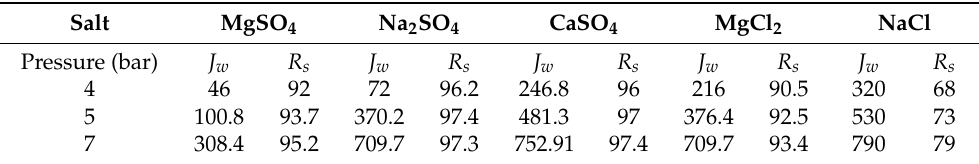
Table 3. The water flux ( J w , L/day) and salt rejection (%) of the NF membrane element as a function of the applied pressure, salt concentration is 2000